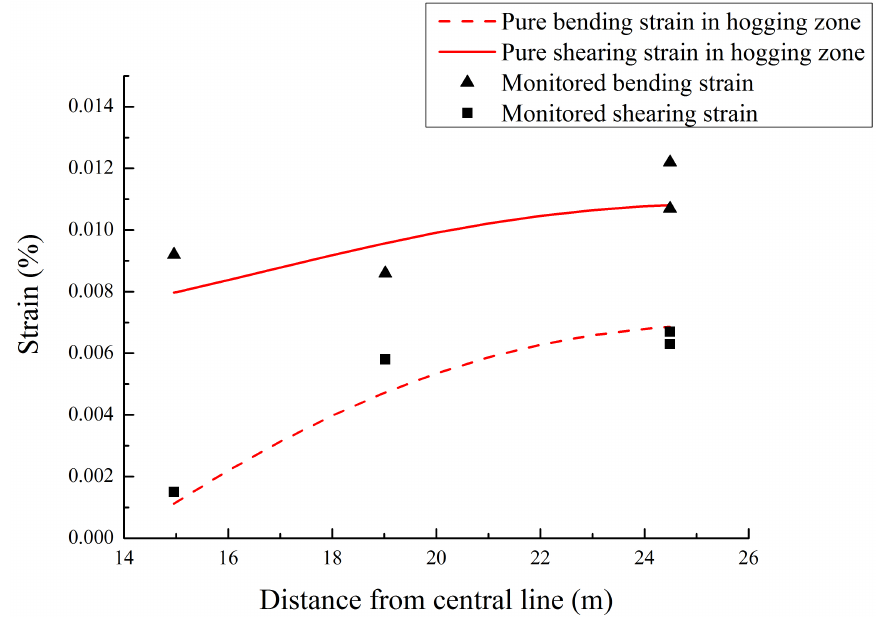
Figure 13. Bending strain and shear strain in the hogging zones.